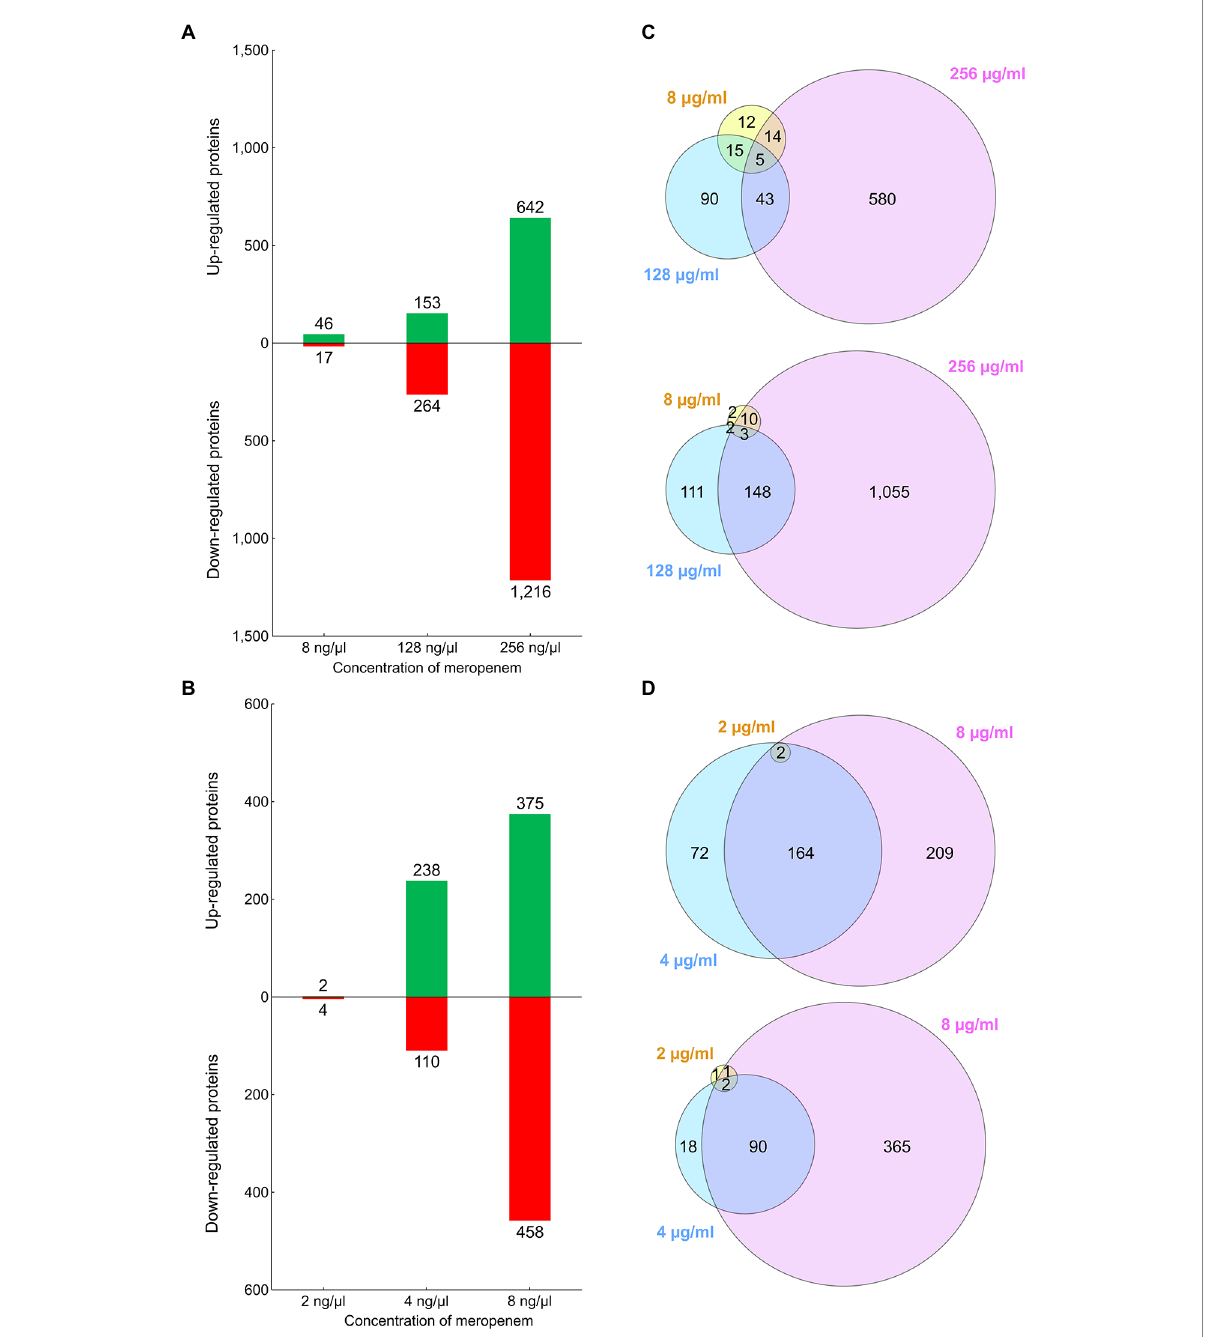
FIGURE 2 (A) Bar graph showing the number of proteins of Pseudomonas aeruginosa CCUG 51971 upregulated or downregulated in each condition. (B) Bar graph showing the number of proteins of P. aeruginosa CCUG 70744 upregulated or downregulated in each condition. (C) Venn diagram showing the number of upregulated or downregulated proteins overlapping between conditions in strain CCUG 51971. (D) Venn diagram showing the number of upregulated or downregulated proteins overlapping between conditions in strain CCUG